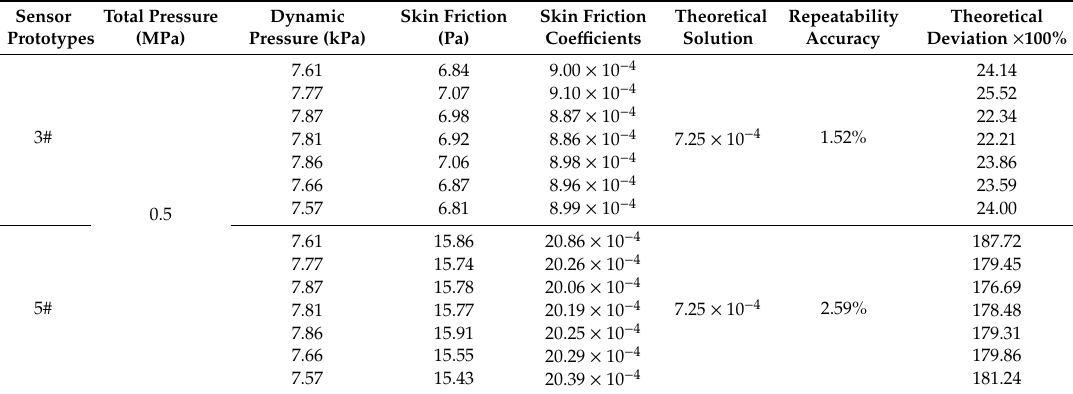
Figure 12. Repeatability test curves under laminar flow conditions. Table 4. The data analysis of repeatability tests under 0.5 Pa total pressure